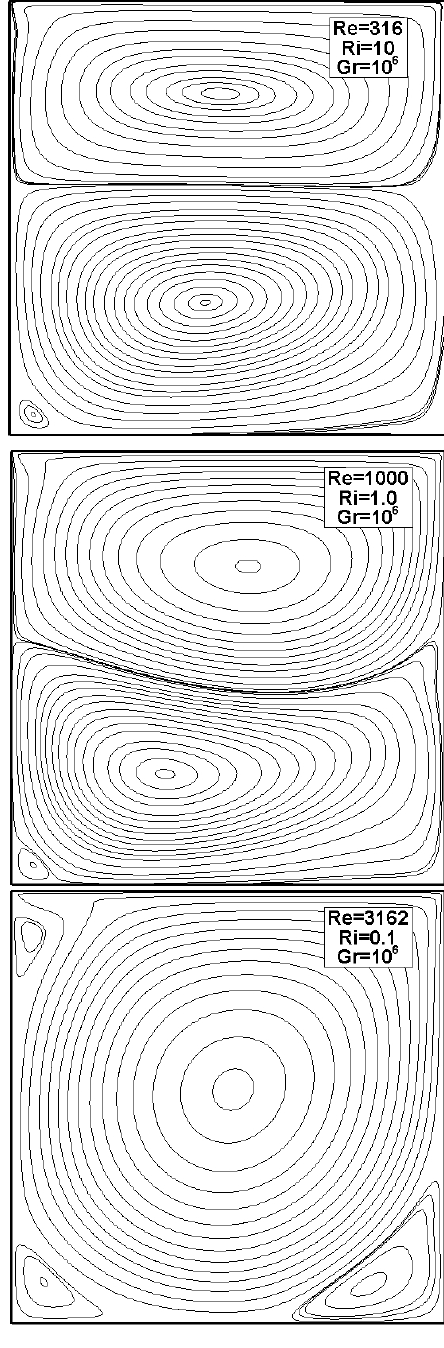
Figure 5. Isotherms and streamlines of mixed convection in a lid-driven cavity: ( Left ) isotherms; and ( Right) streamlines.